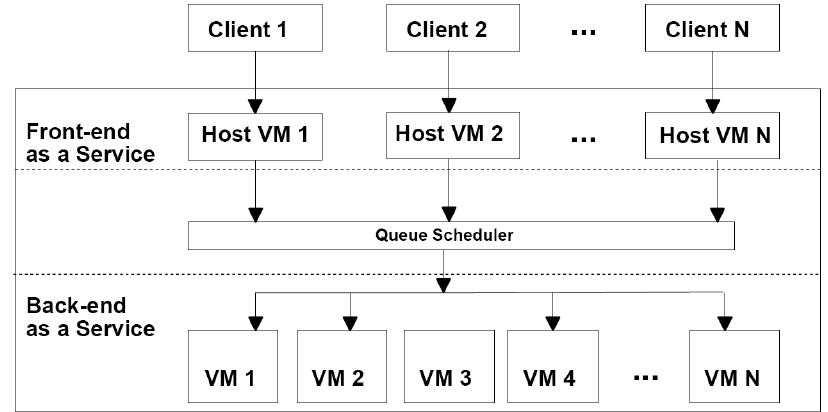
Figure 3. Virtualization of cloud resources in a physical machine (PM). VM, virtual machines.